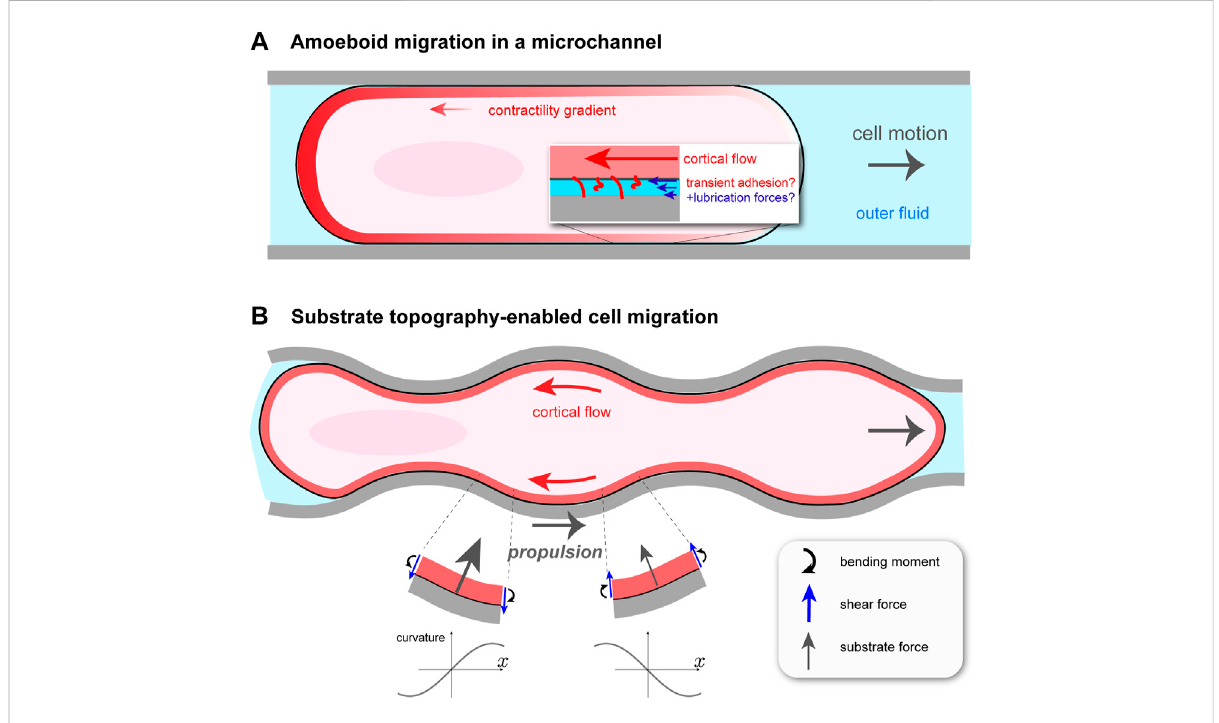
FIGURE 1 Cortical fl ow-based migration in con fi nement. (A) Illustration of non-speci fi c friction mediated cell motion in a cylindrical microchannel Bergertetal.(2015).Rearwardcortical fl owisdrivenbyagradientincontractility ζ ( x ),andmomentumisthoughttobetransferredtothesurroundings bytransient adhesionandlubrication forces.Thechannelis fi lledwith fl uid,whichhydraulicallyresistscellmigration. (B) Migrationoftalinknock-out leukocyteinawavychannelReversatetal.(2020).Substratetopographyforcesthecortical fl owtobecurvilinear,creatingbendingstressesand, asaresult,anasymmetricpro fi leinnormally-orientedsubstrateforces.Thisgivesrisetoanetpropulsionforceinthedirectionoppositetothatofthe cortical fl